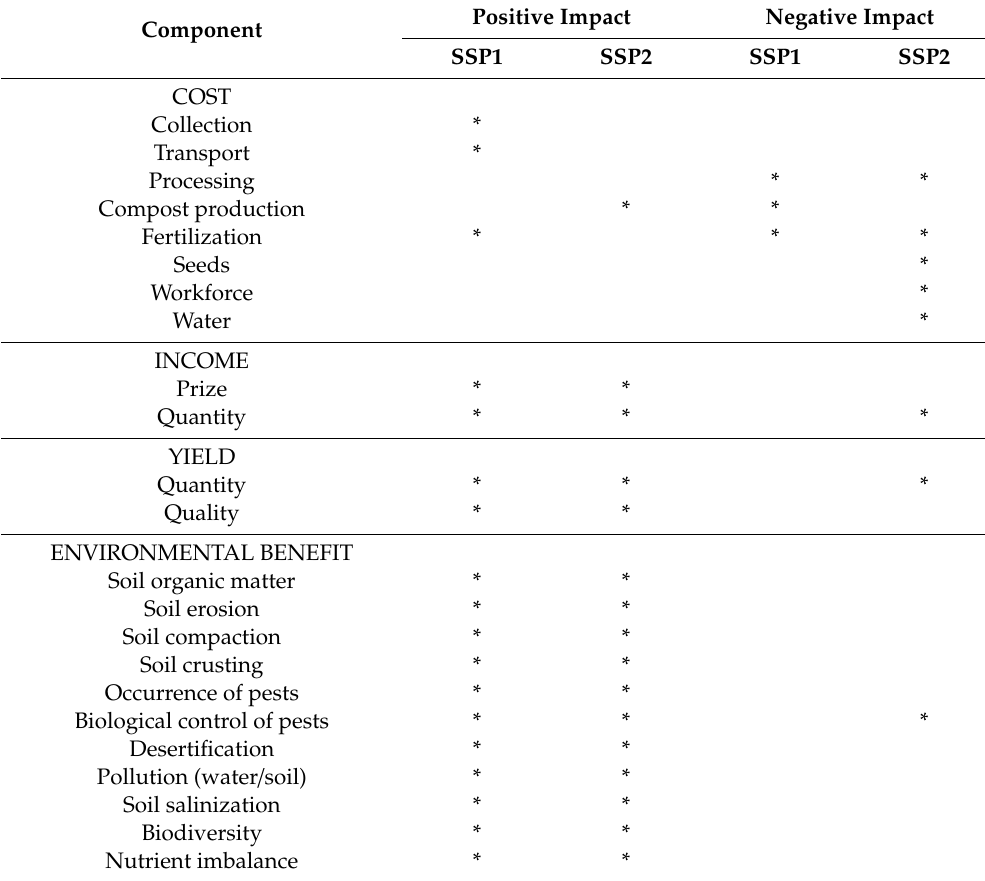
Table 2. Main impacts of adopting the Soil Sustainable Practice (SSP) in the study